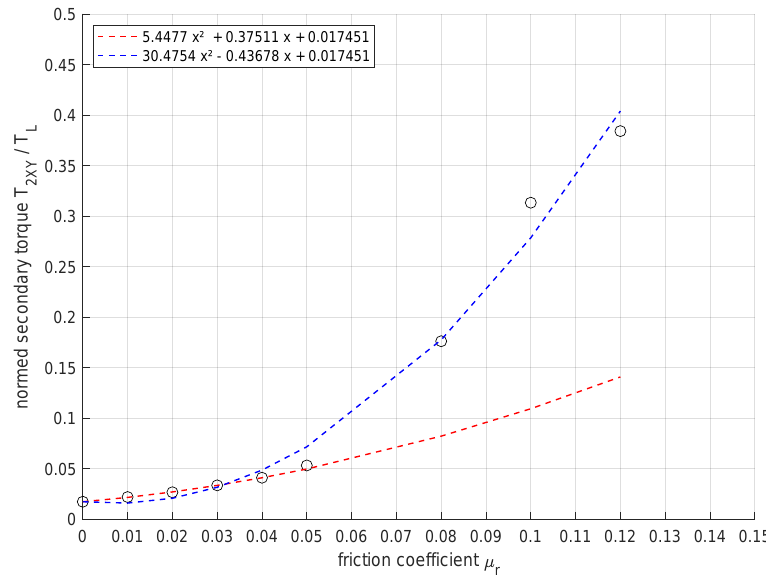
Figure 11. Secondary torque at 2 ◦ deflection angle and a load torque of 2000 Nm for different friction